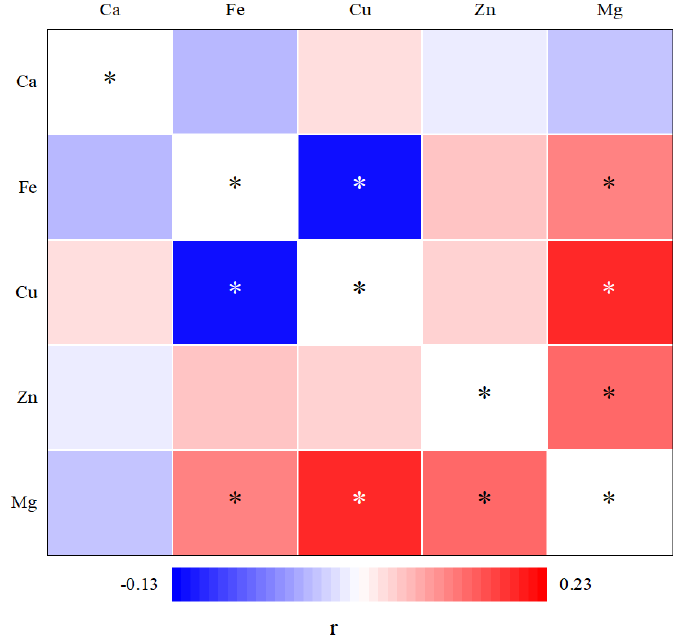
Figure 2. The correlation of different whole blood mineral elements. r: correlation coefficients. *: p < 0.05, the p − value was adjusted using false discovery rate method for multiple testing. Table 3. Partial correlation analysis of mineral elements with erythrocyte FAs in children.